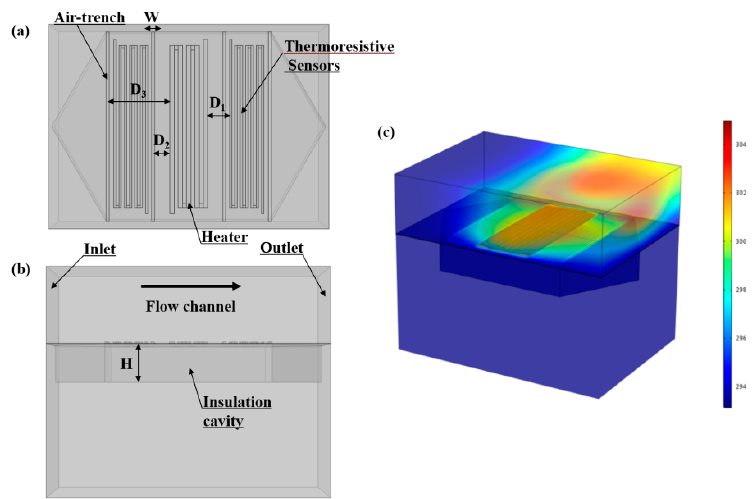
Figure 2. Three-dimensional simulation model of the gas flow sensor. ( a ) Top view of simulation model (D 1 , the distance between the thermistors and the heater; W, the width of the air-trench; D 2 or D 3 , the distance between the air-trench and the heater). ( b ) Front view of simulation model (H, the depth of the thermal isolation cavity). ( c ) Temperature distribution diagram of the flow sensor.